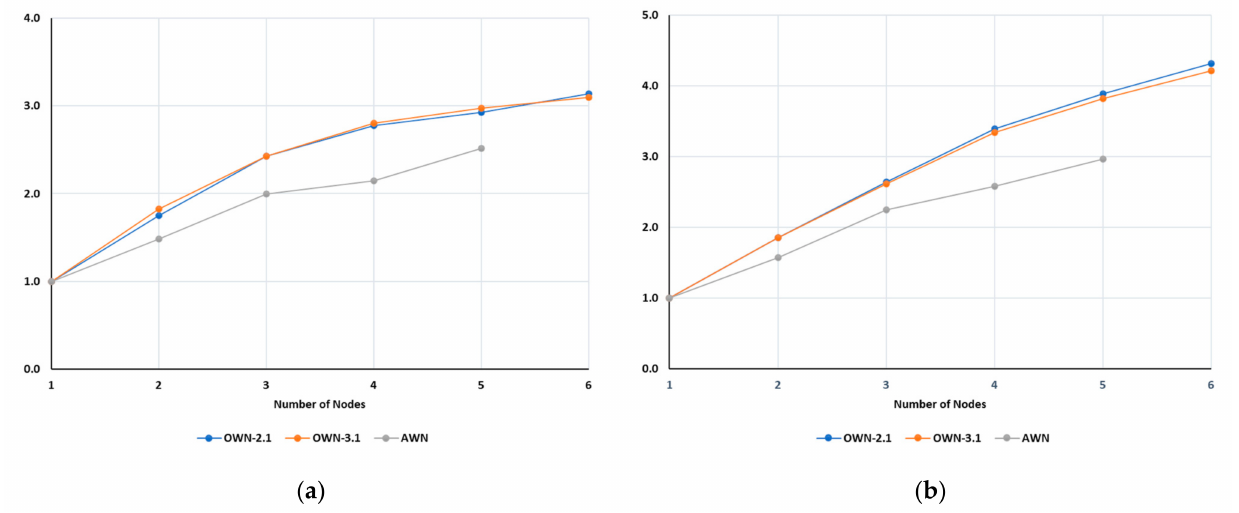
Figure 5. Speedup with the number of multi-nodes in the ALC and OCI for ( a ) small and ( b ) large